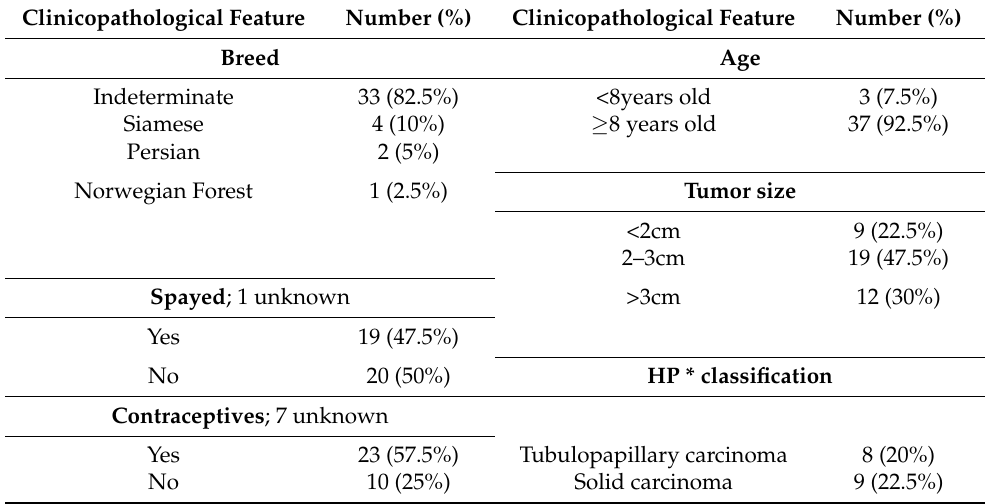
Table 3. Clinicopathological features of female cats with mammary carcinomas enrolled in this study (n =